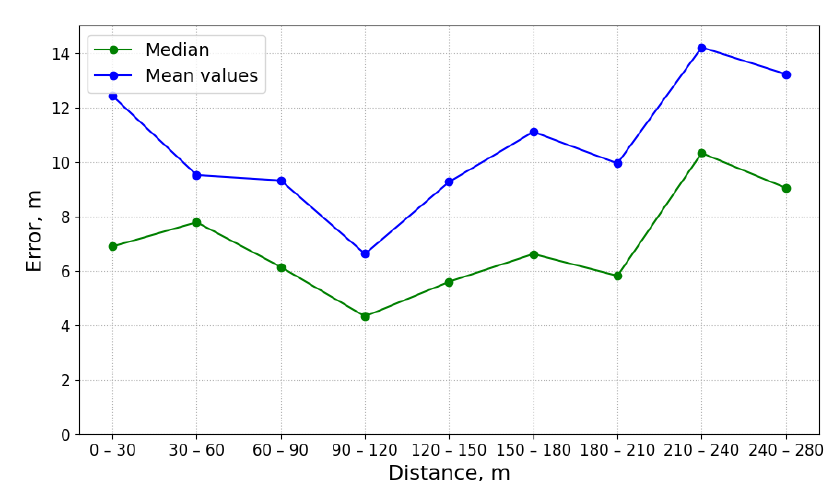
Figure 12. This figure presents the correlation between the prediction error, mean value and the median, and the distance at which the measurements were taken.